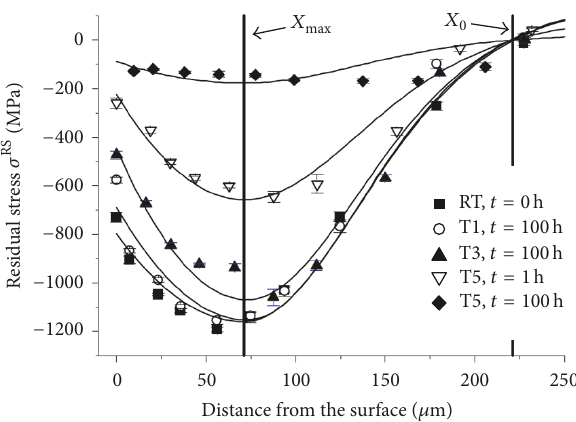
Figure 12: Shot peening residual stress depth distributions for various heat relaxation treatments (RT: room temperature; 𝑋 max = 70 𝜇 m and 𝑋 0 = 220 𝜇 m) [16].